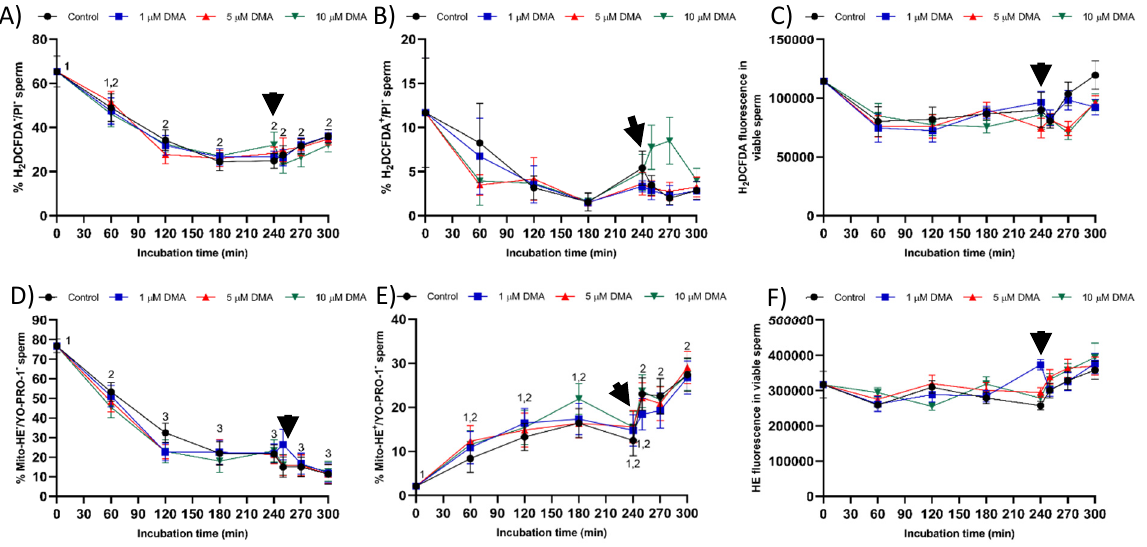
Figure 11. Percentages of sperm with low ( A , D ) and high ( B , E ) ROS and superoxide levels, and fluorescence intensity of DCF + or E + in viable sperm with high overall ROS ( C ) and superoxide ( F ) levels during in vitro capacitation in the control and samples blocked with 1, 5, and 10 µ M DMA. Different numeral superscripts indicate significant differences between two consecutive time points within a treatment ( p < 0.05); since the pattern of variation of each sperm parameter throughout the incubation time was similar between control and blocked samples, all treatments have the same numeral superscript assigned to each time point. Lack of numeral superscripts indicate no significant differences in the percentage of viable sperm with high ROS levels, and in DCF + and E + fluorescence intensity. The arrow indicates the addition of 10 µ g/mL of progesterone at 240 min of incubation. Results are expressed as the mean ± SEM ( n = 9).